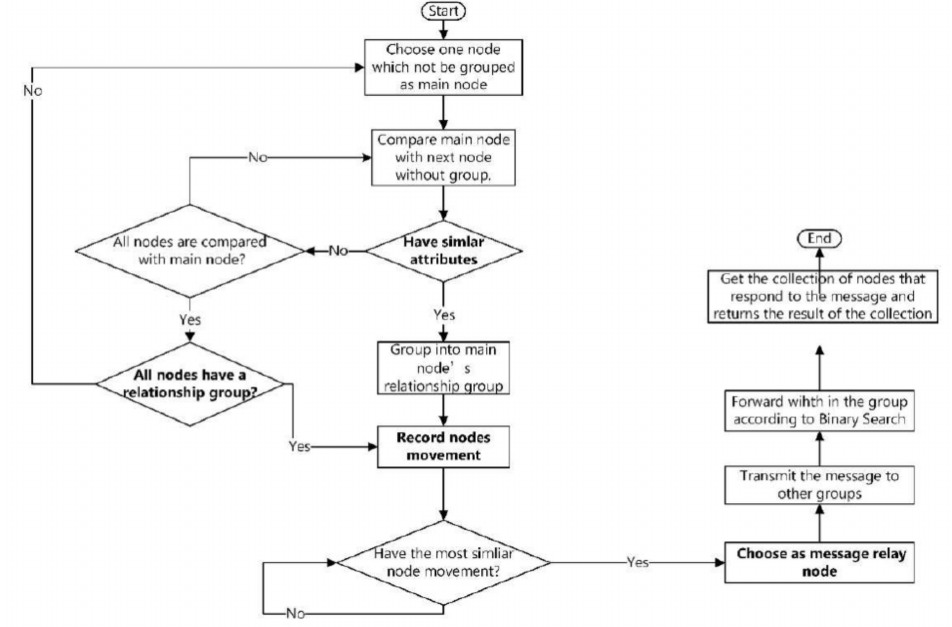
Figure 2. Algorithm